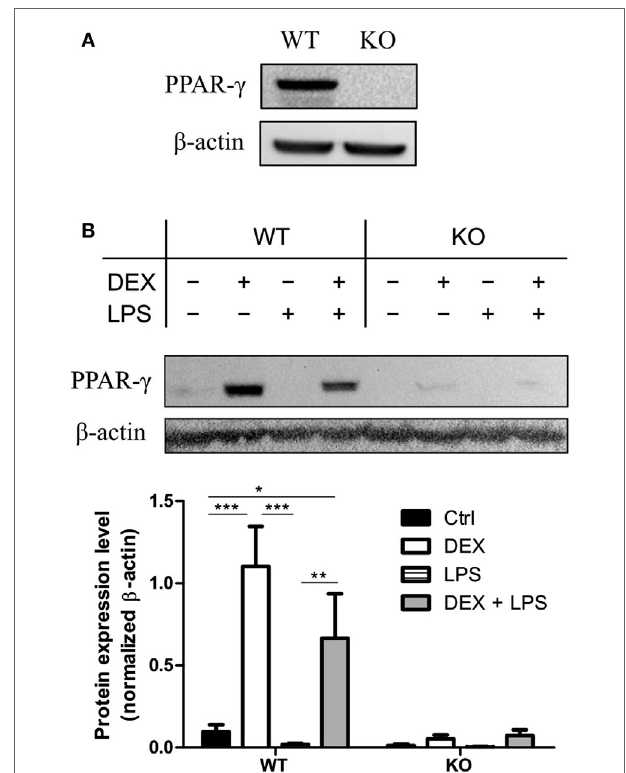
FigUre 1 | Dexamethasone (DEX) stimulation leads to the upregulation of peroxisome proliferator-activated receptor (PPAR)- γ . (a) Western blot of PPAR- γ was performed with ER-Hoxb8 macrophage progenitor cells stimulated with DEX for 24 h. β -Actin was used as a loading control. (B) ER-Hoxb8 cells were differentiated to macrophages for 5 days and stimulated with DEX (100 nM) and/or LPS (1 µg/ml) for 24 h. The upper part displays an immunoblot from one representative experiment including the β -Actin loading control. The lower part shows the quantification of western blot results from three independent experiments. The signal intensity of PPAR- γ was divided by the signal intensity of β -Actin, which served as a loading control. (a,B) The bars represent the mean with the SEM of